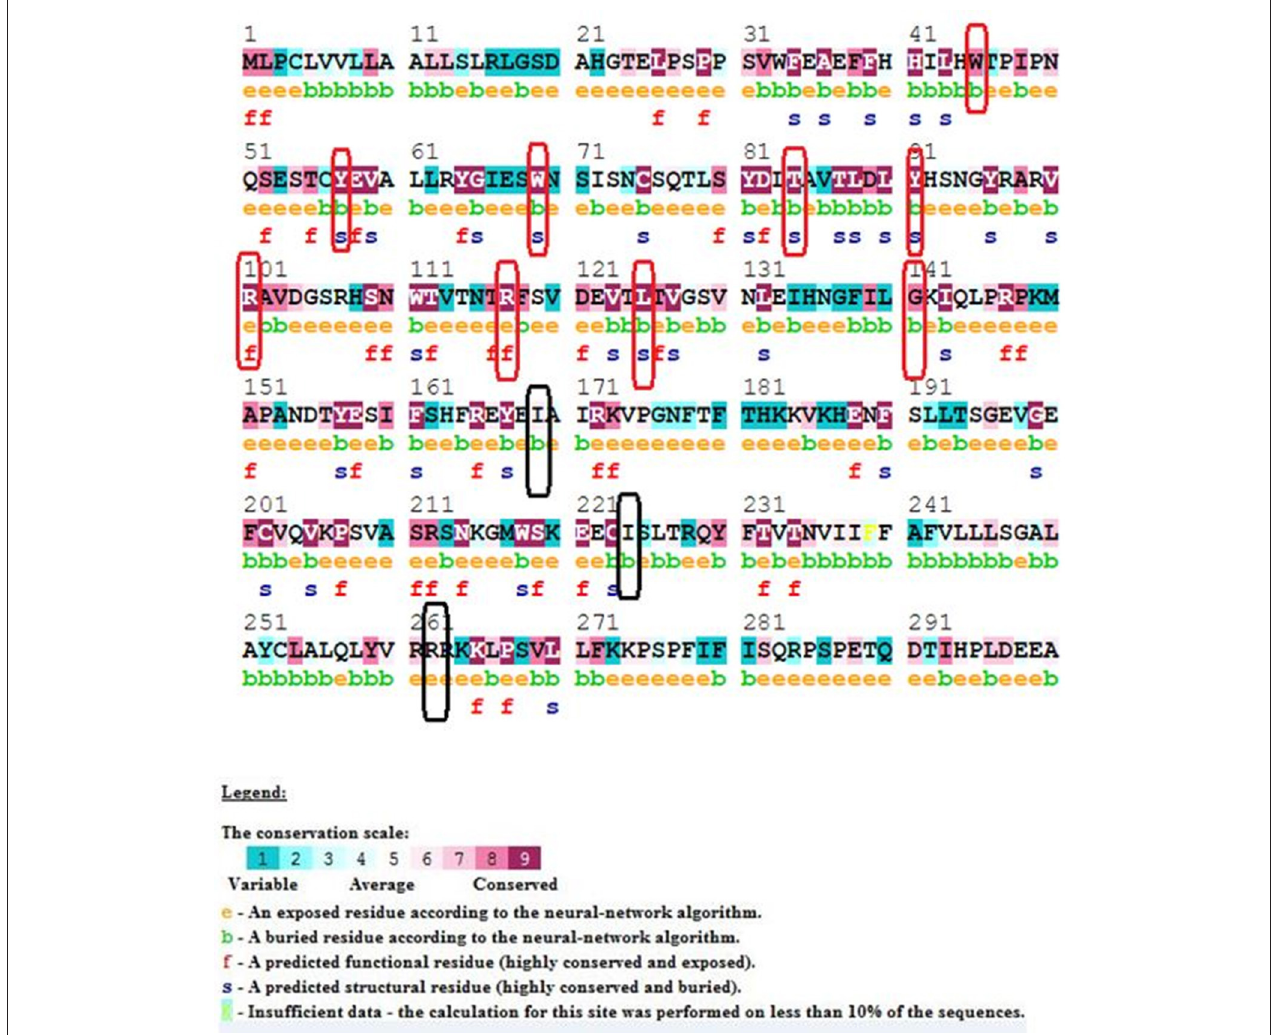
FIGURE 1 | ConSurf Output of selected IL10RA mutants. Wild-type sequence of IL10RA with its conservation scale; highly conserved residues in red rectangle; average conserved residues in black rectangles.